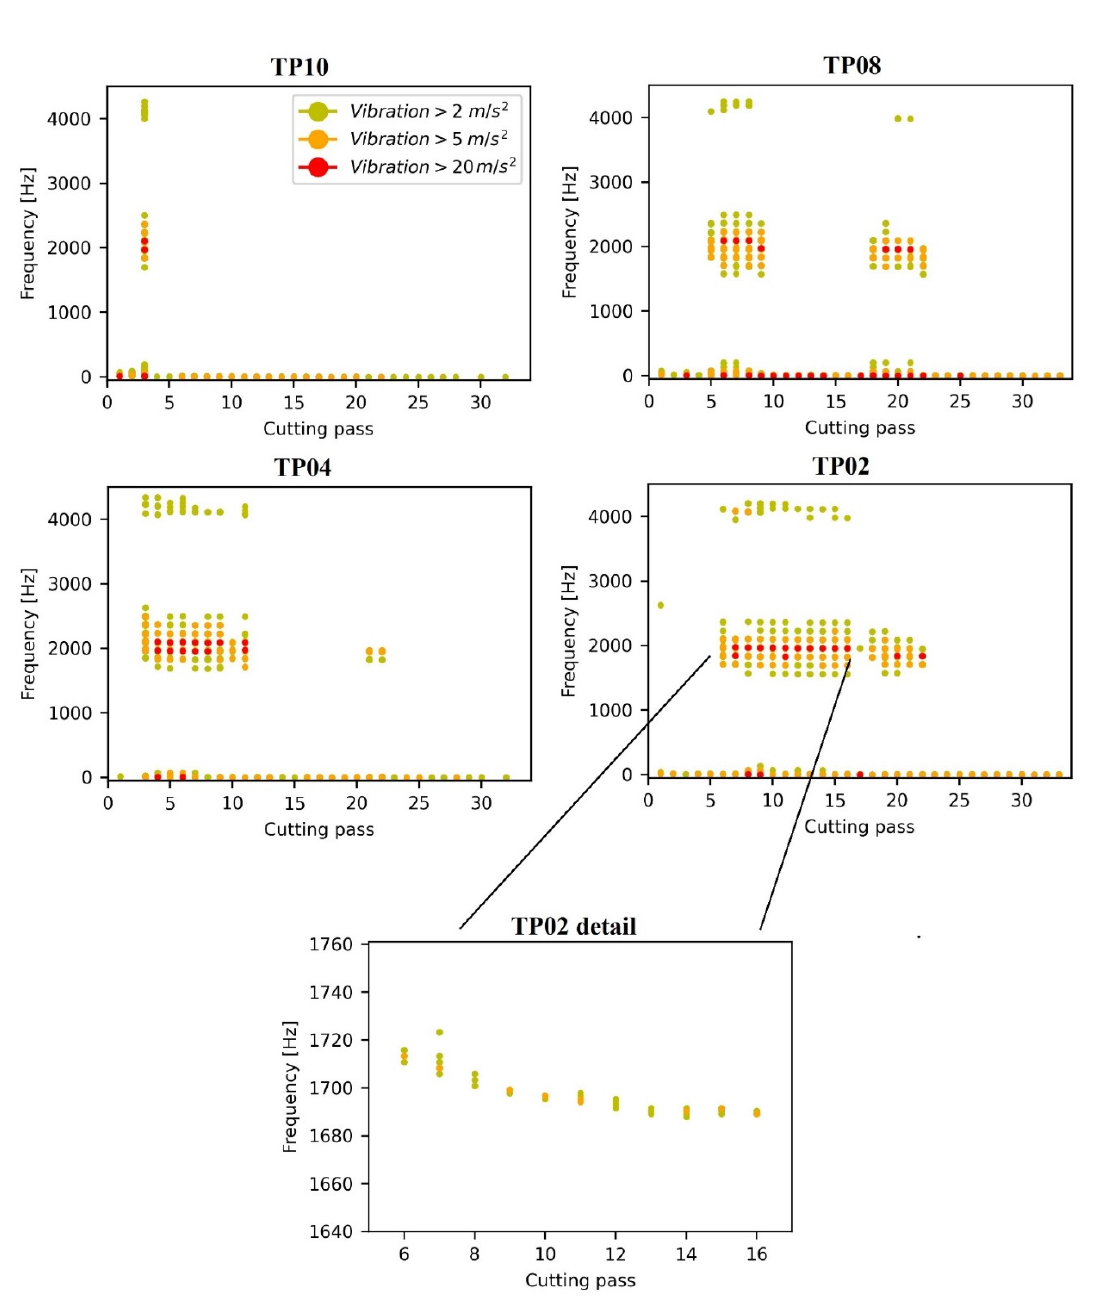
Figure 8. Frequencies with maximum vibration content per cutting pass, and TP02 detailed image.